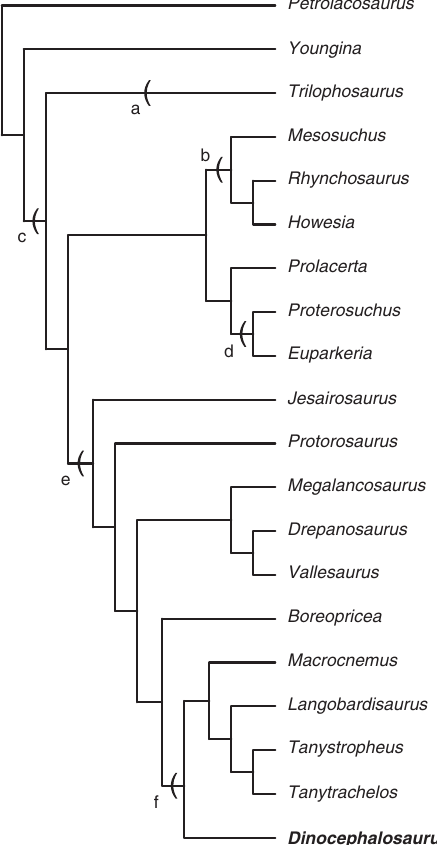
Figure 4 | Phylogenetic hypothesis of Dinocephalosaurus . Key clades are indicated: a Trilophosauria, b Rhynchosauria, c Archosauromorpha, d Archosauriformes, e Protorosauria and f